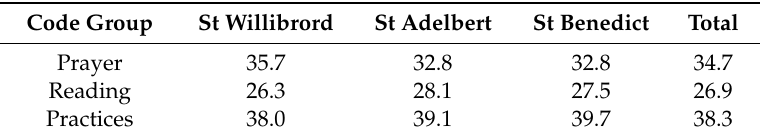
Table 1. Code groups and monastic